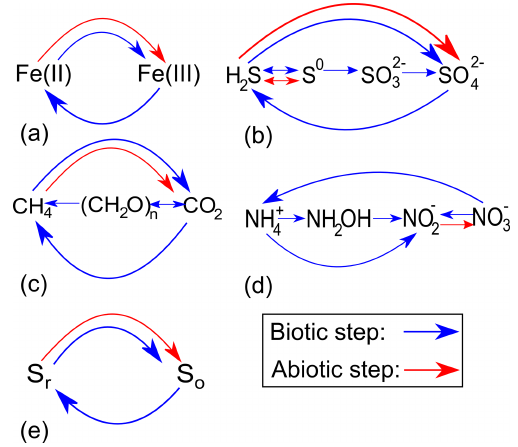
Figure 1. Schematic view of the biogeochemical redox cycles in- volving iron, sulfur, carbon, and nitrogen (a–d) (Falkowski et al., 2008; Fenchel et al., 1998; Galloway et al., 2004; Canfield et al., 2005), together with the model investigated in the first part of this work (e) . In all panels, oxidation reactions proceed to the right, and reduction reactions proceed to the left. Biologically catalyzed (metabolic) reactions are shown in blue, and abiotic reactions are shown in red. We note that abiotic reduction reactions are not shown, as these are minor reactions in the natural environment (but can be included in our model; see Sect. S1). We also note that many intermediate chemical states are not shown (particularly for the ni- trogen and sulfur cycles) but inclusion of extra states does not affect our conclusions; see Supplement. In panel (e) , s r and s o represent the reduced and oxidized forms of the chemical element being cy-